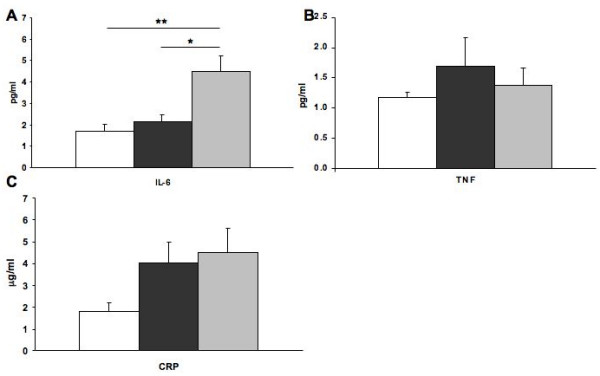
Serum IL-6, TNF, and C-reactive protein levels. For each subject, serum levels of A) IL-6 and B) TNF were quantified by ELISA. C) Serum CRP levels were quantified by high sensitivity nephelometry. Columns represent mean ± SEM. *p = 0.002; **p = 0.0003. Normal non-smokers (white), normal smokers (black), and emphysematous smokers (grey).